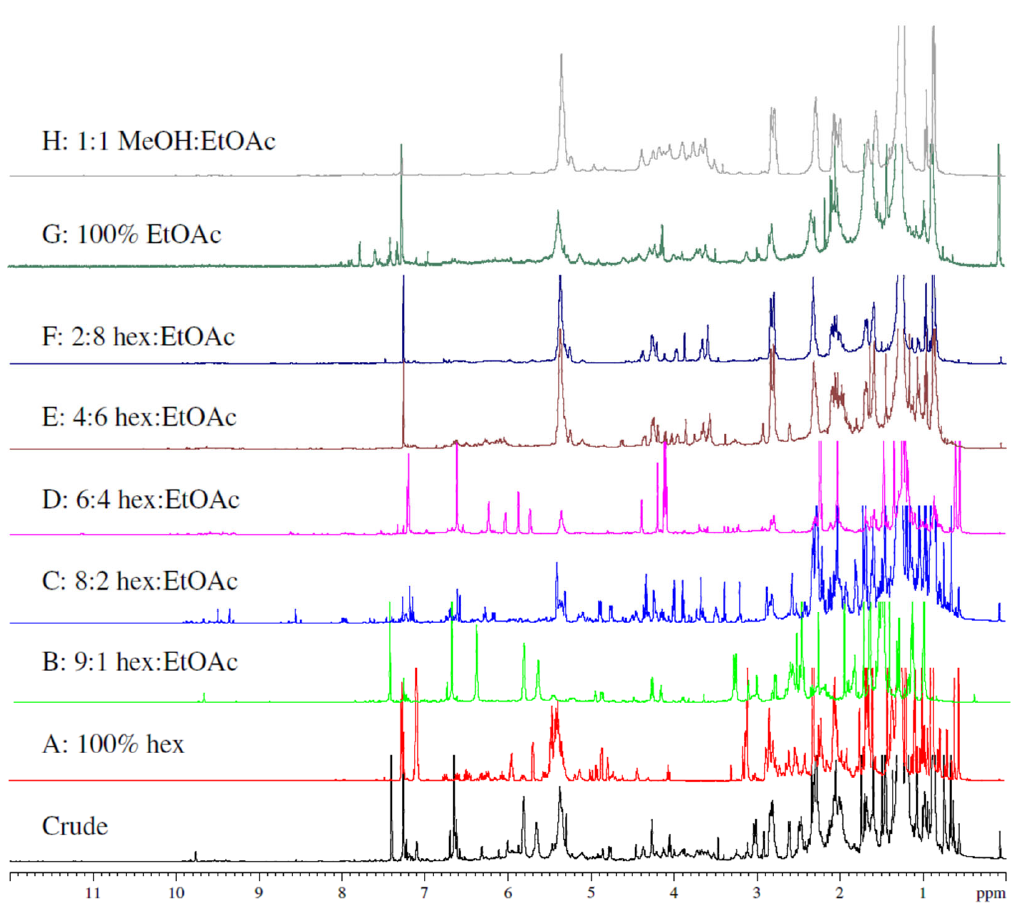
Figure 2. 1 H NMR spectra (CDCl 3 , 600 MHz) of the crude organic extract of L. corymbosa and the column fractions A–H. Abbreviations: Hex: hexane; EtOAc: ethyl acetate; MeOH: methanol.